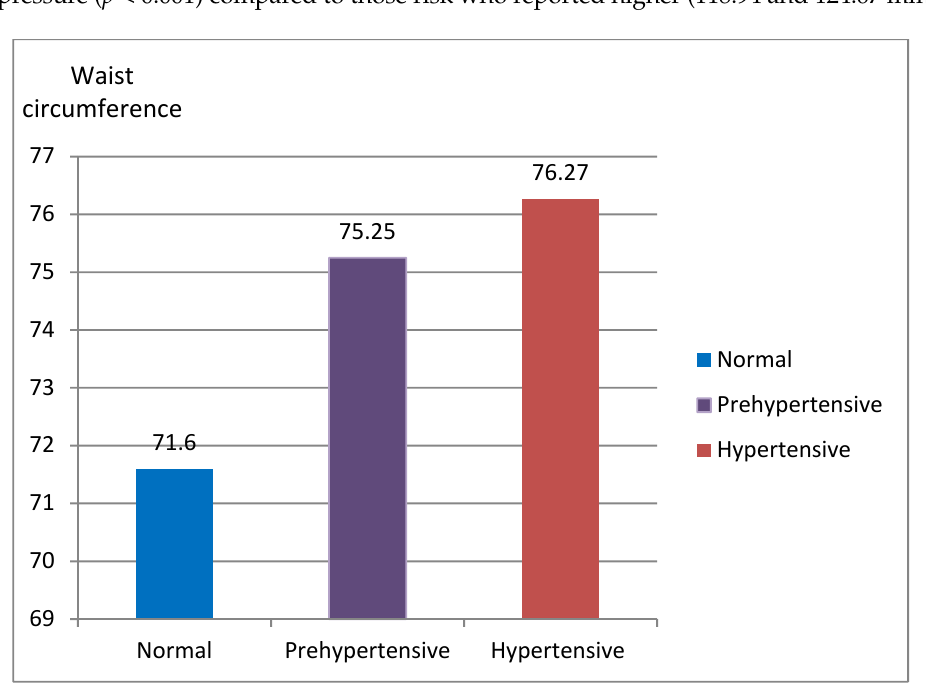
Figure 1. WC for youth across blood pressure classifications.